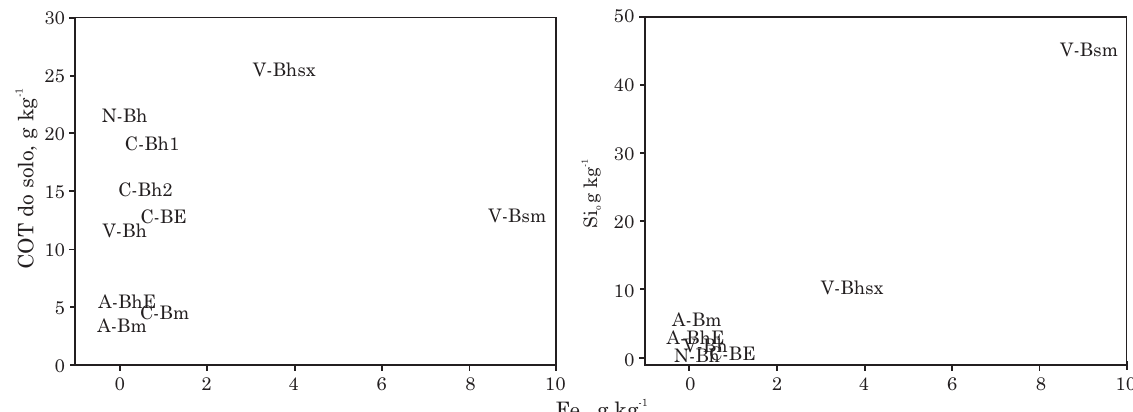
Figura 6. Dispersão de pontos entre Fe extraído por oxalato ácido de amônio (Fe o ) e C orgânico total do solo (COT) e Si extraído por oxalato ácido de amônio (Si o ) de amostras dos horizontes iluviais e C estudados. Primeira parte da legenda representa o perfil do solo – C: Coruripe floresta (EKo), N: Neópolis coco (EKg), A: Acajutiba eucalipto (RQo) e V: Nova Viçosa eucalipto (ESKo). Segunda parte da legenda retrata o horizonte genético do